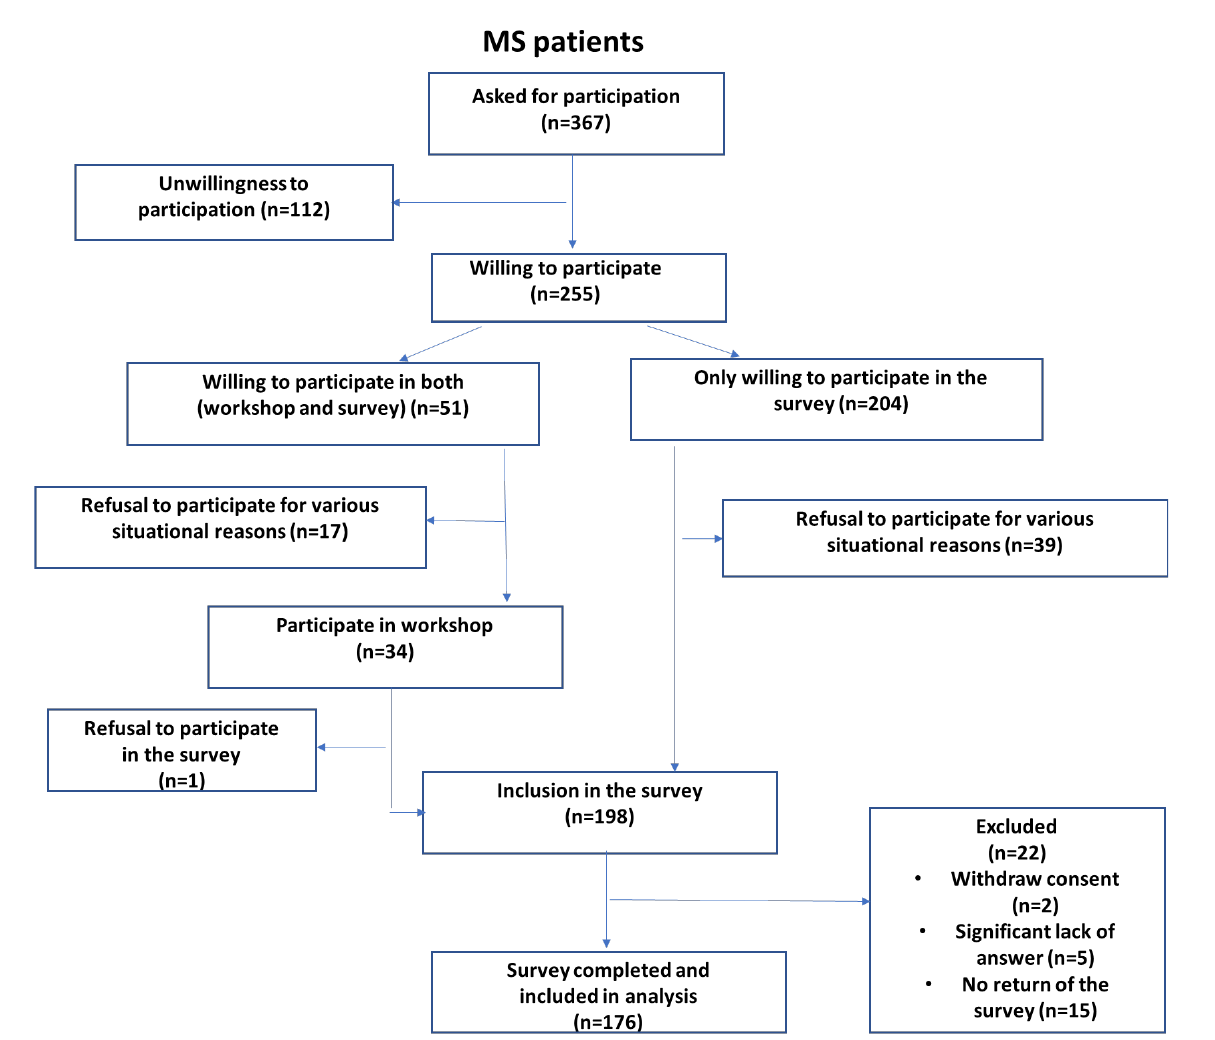
Figure 1. MS patients recruitment flow chart.